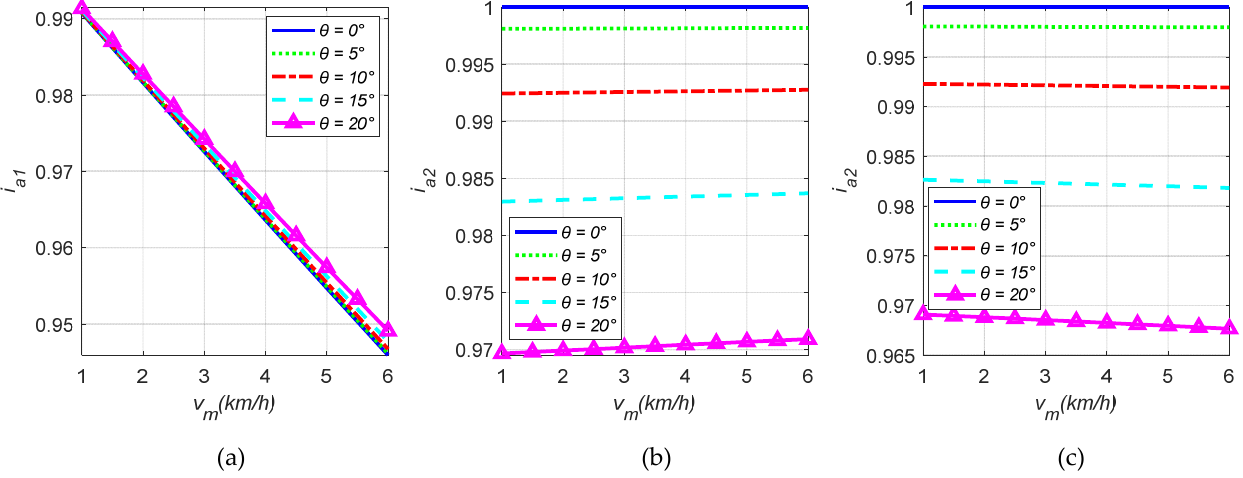
Figure 10. Effects of v m and θ on i a 1 and i a 2 : ( a ) effects of v m and θ on i a 1 ; ( b ) effects of v m and θ on i a 2 in up-grinding; ( c ) effects of v m and θ on i a 2 in down-grinding.